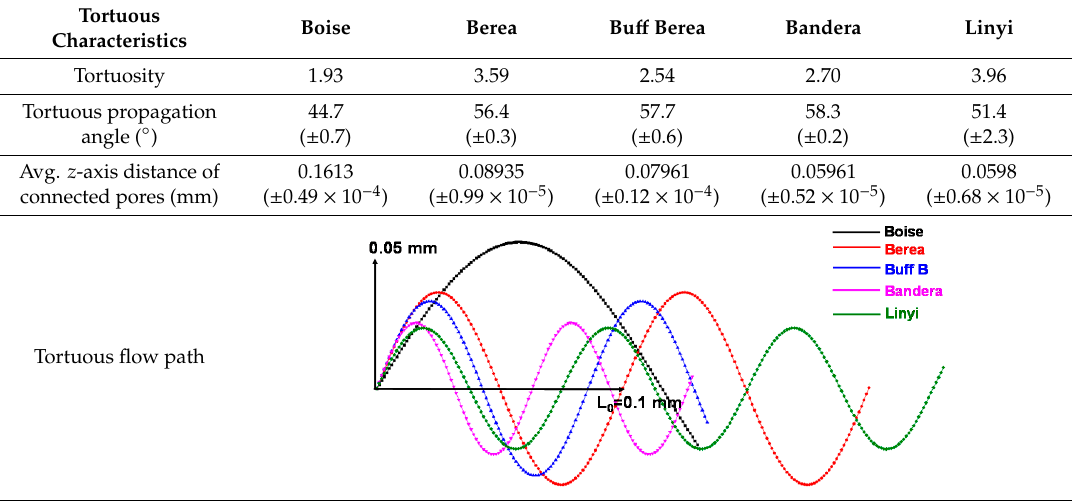
Table 8. Tortuosity factors determined solely from the apparent pore phase of each sandstone.